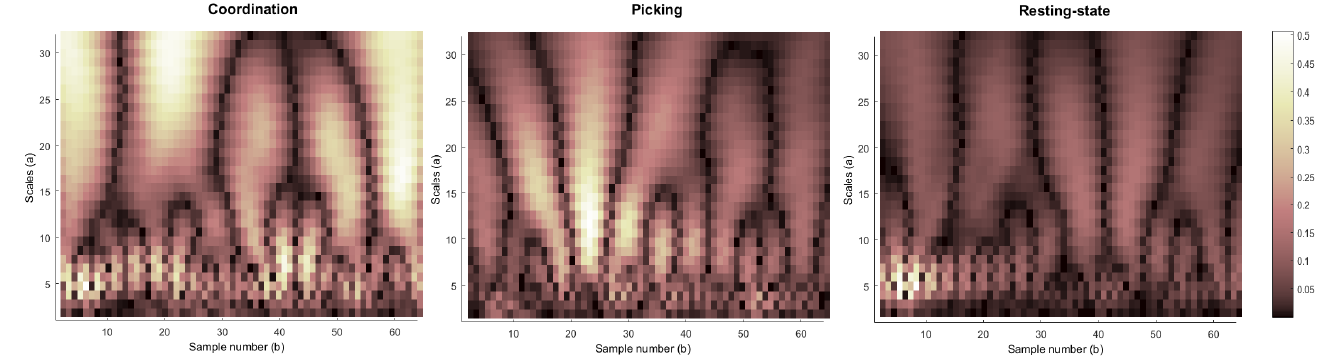
Figure 4. CWT results in different experimental states (resting, picking, and coordination).